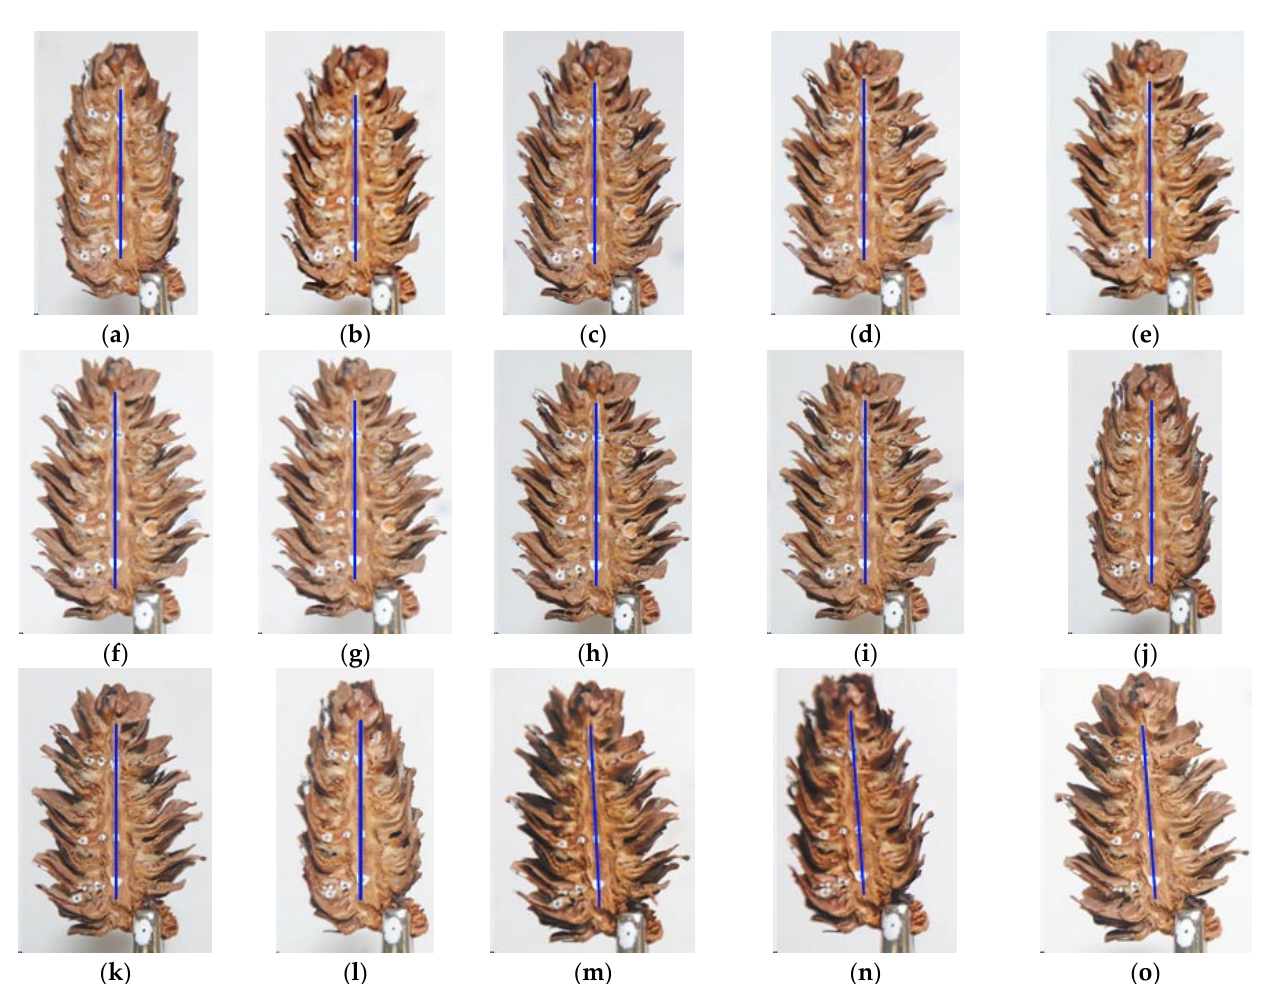
Figure 3. Opening states of an individual cone on the first day of seed extraction as well as at the beginning and 8 h into the process over the following days; day 1: ( a )—initial state, ( b )—at 1 h, ( c )—at 2 h, ( d )—at 3 h, ( e )—at 4 h, ( f )—at 5 h, ( g )—at 6 h, ( h )—t 7 h, and ( i )—at 8 h; day 2: ( j )—initial state, ( k )—at 8 h; day 3: ( l )—initial state, ( m )—at 8 h, and day 4: ( n )—initial state, and ( o )—at 8 h.